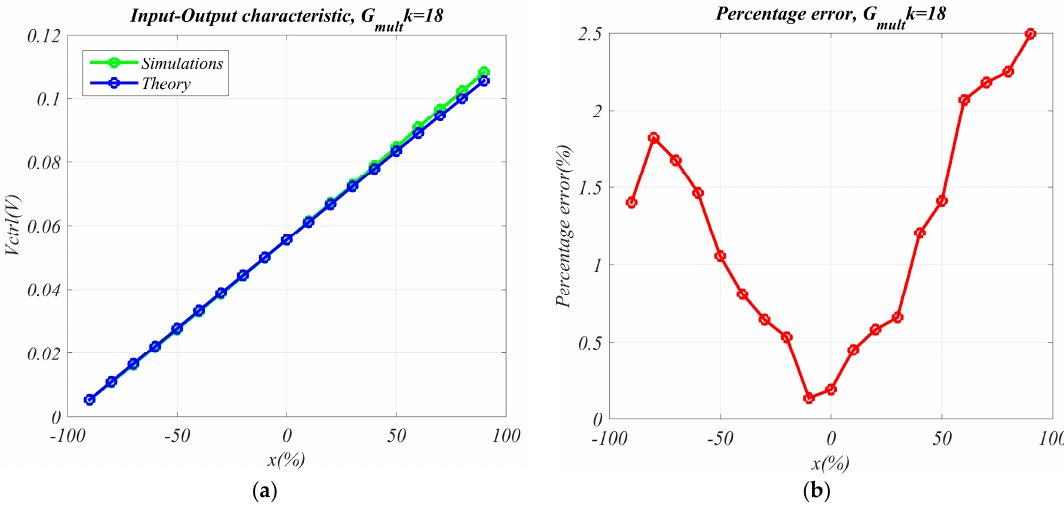
Figure 3. ( a ) Interface Input ( x %)—Output ( V ctrl ) response; ( b ) % percentage relative error between theory and simulation.